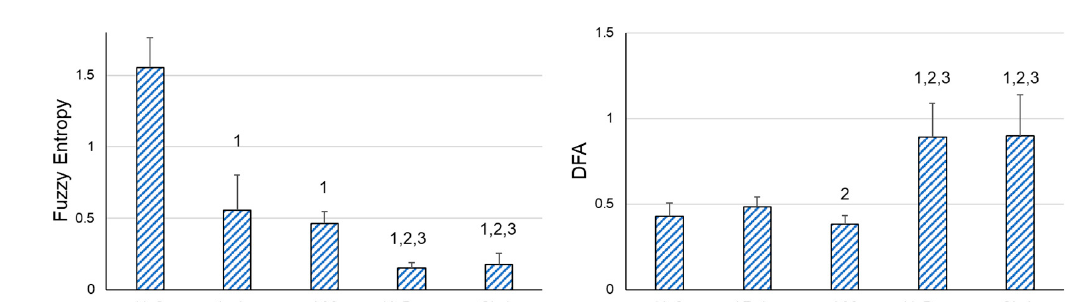
Figure 2. Pairwise Comparisons between the different situations. DFA = Detrended Fluctuation